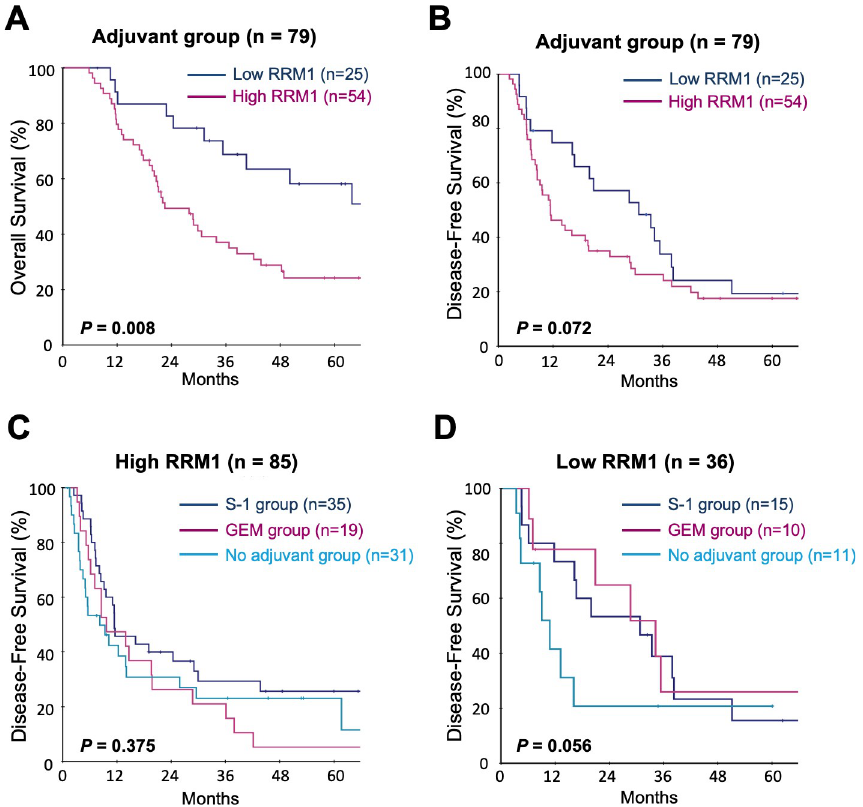
Fig 2. Correlation between the level of expression of RRM1 and postoperative outcomes in patients who received adjuvant chemotherapy. Kaplan-Meier curve for overall survival (A) and disease-free survival (B) of 79 patients who received adjuvant chemotherapy. Kaplan-Meier curve for disease-free survival of 85 patients with high RRM1 expression (C) and 36 patients with low RRM1 expression (D) in the comparison of receiving adjuvant chemotherapy and no adjuvant chemotherapy. S-1 group: patients who received S-1 adjuvant chemotherapy. GEM group: patients who received gemcitabine adjuvant chemotherapy. No adjuvant group: patients who received no adjuvant chemotherapy,